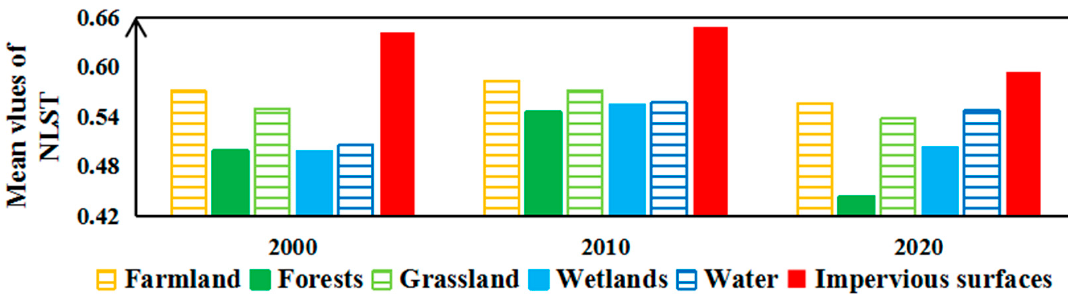
Figure 6. Normalized land surface temperature (NLST) in Hangzhou City from 2000 to 2020.